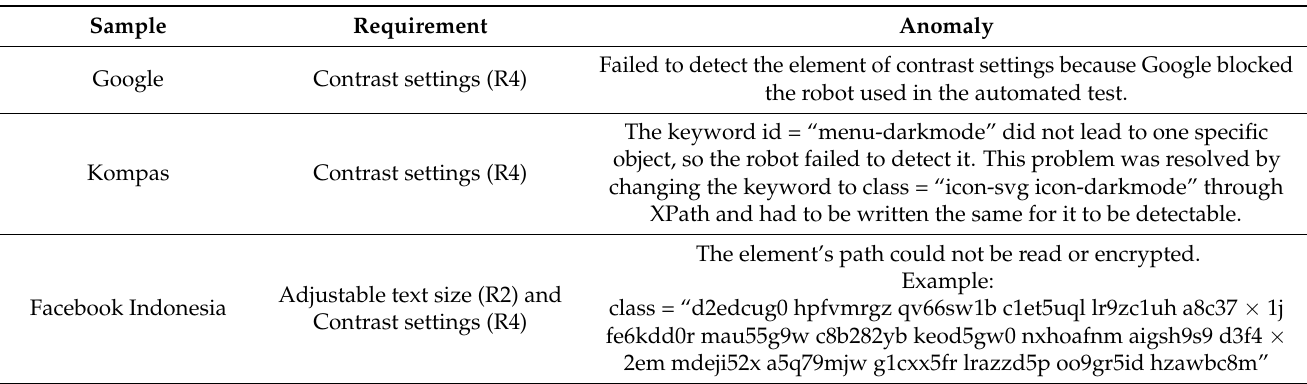
Table 5. Anomalies of differences in test